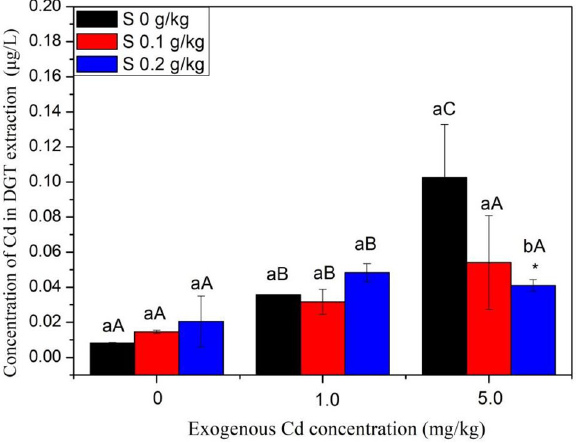
Figure 2. Concentration of DGT-extractable Cd in different rice rhizosphere soil. Different lowercase letters within biomass for rice indicates a significant difference among different S levels at P < 0.05. Different capital letters within biomass for rice indicates a significant difference among different Cd treatments at P < 0.05.